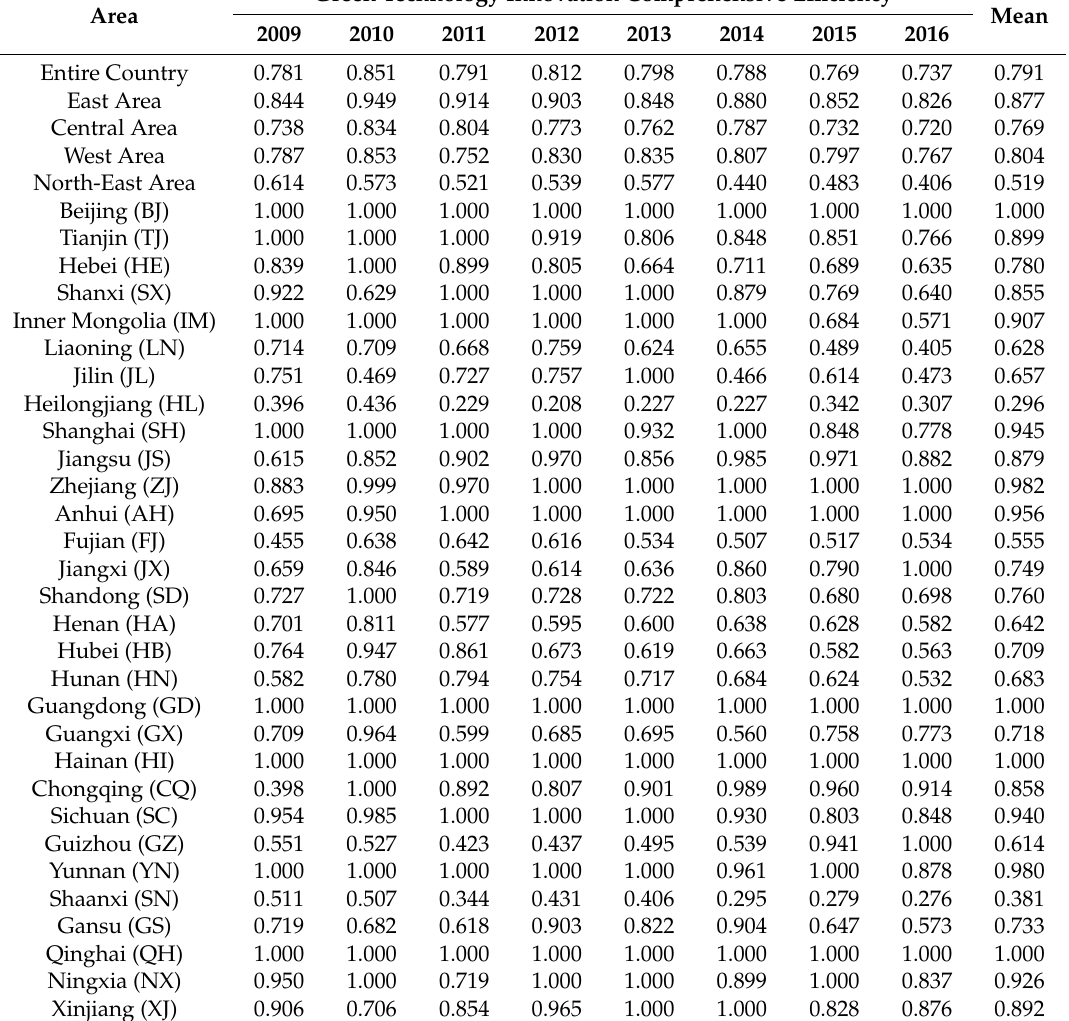
Table 5. China’s industrial enterprises’ green technology innovation comprehensive efficiency (2009–2016). Green Technology Innovation Comprehensive Area